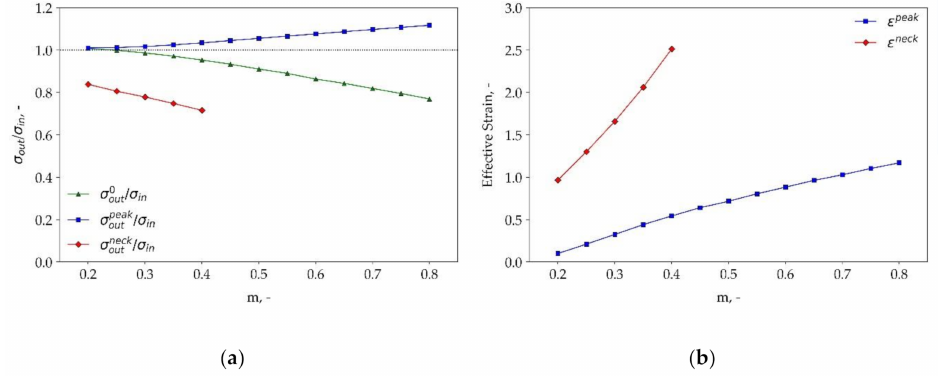
Figure 7. The e ff ect of strain-rate sensitivity ( m ) on the apparent strain hardening and softening: ( a ) the initial, peak, and necking stresses related to the m value; ( b ) the relations of the peak strain and the necking strain on the m